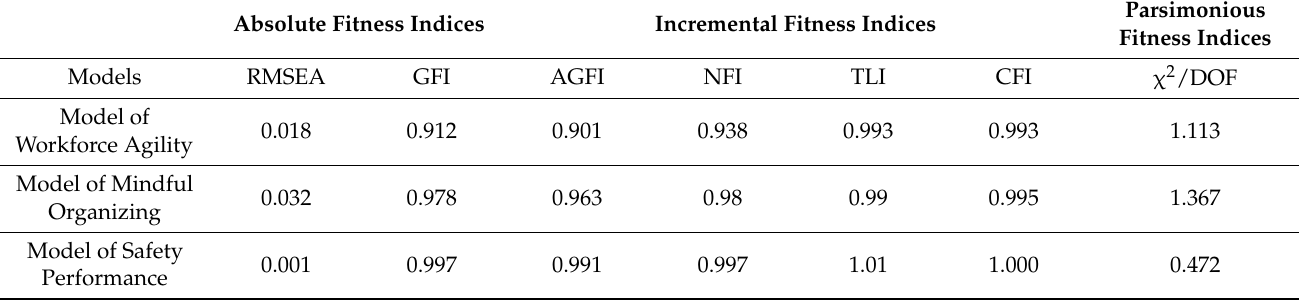
Table 3. Fitness indices for the measurement